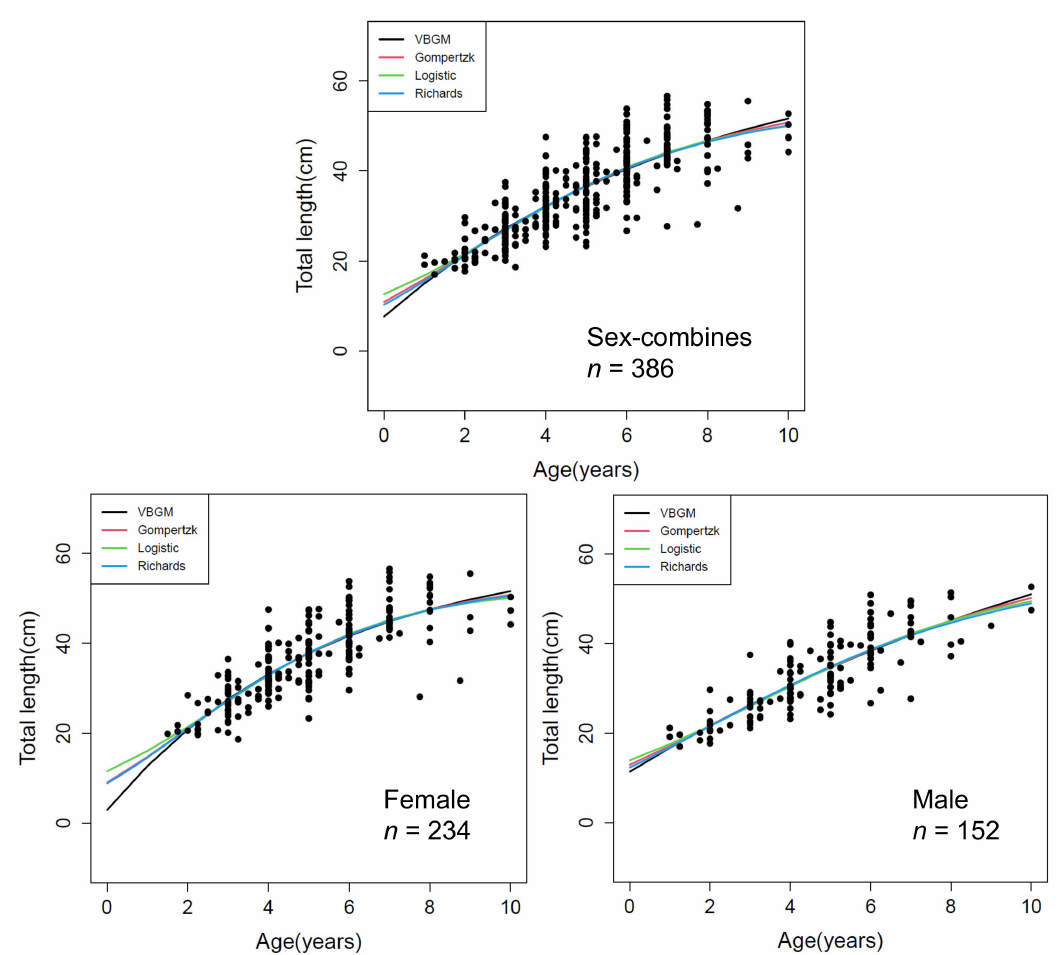
Figure 7. Age and length of sex-combined and sex-separated data and fitted growth curves of the three growth models for A. nibe off southwestern